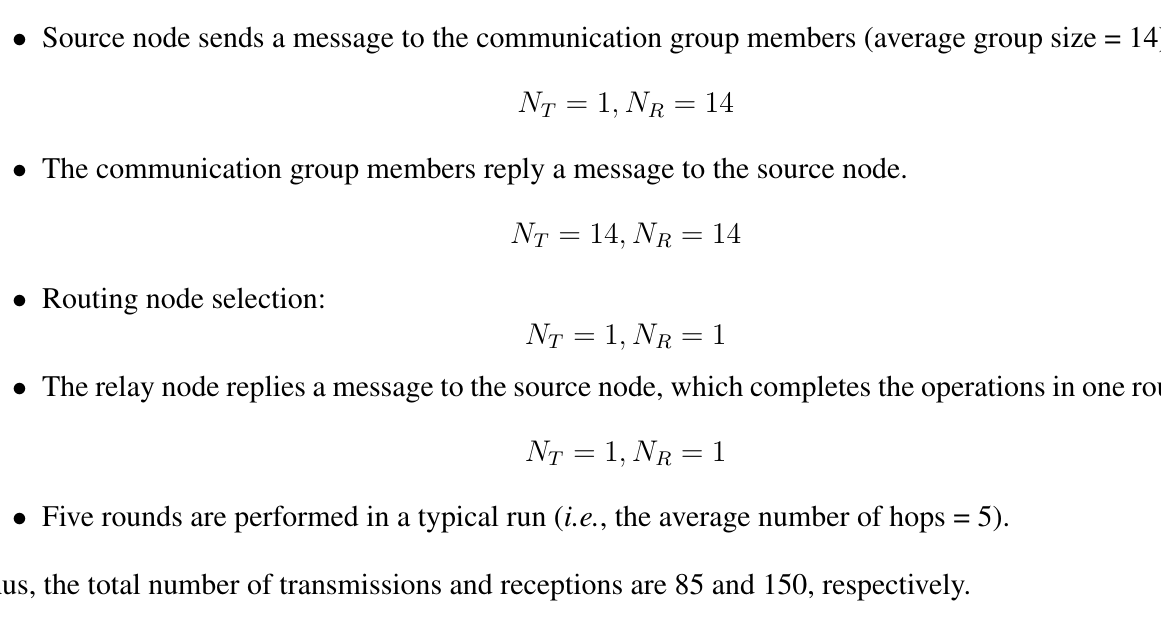
Figure 21. The communication complexity of the HDTC scheme, cone-based scheme and distance scheme under Scenarios 1, 2 and 3,